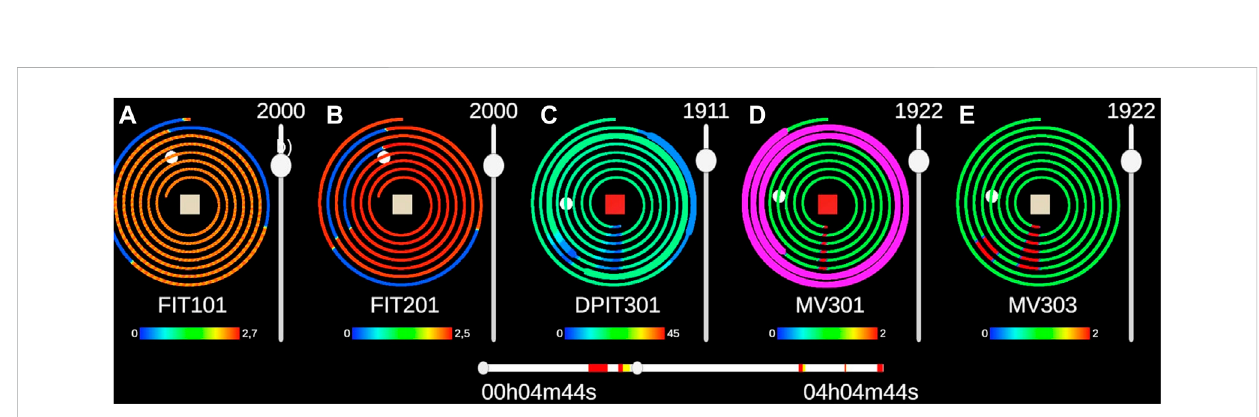
FIGURE 5 The fi ve sensors of set1 are represented with the 2D interface. The timeline in the middle enables users to select the period displayed. The interface used to answer alerts is pictured at the bottom. We can see a false negative on MV303 as there is a clear break within the periodic pattern. A click on the redbutton atthecenterofthespiral ofDPIT301 highlights thetwo alerts present intheselected time frame. When theyarenot highlighted,thethickness of the spirals indicates the presence of